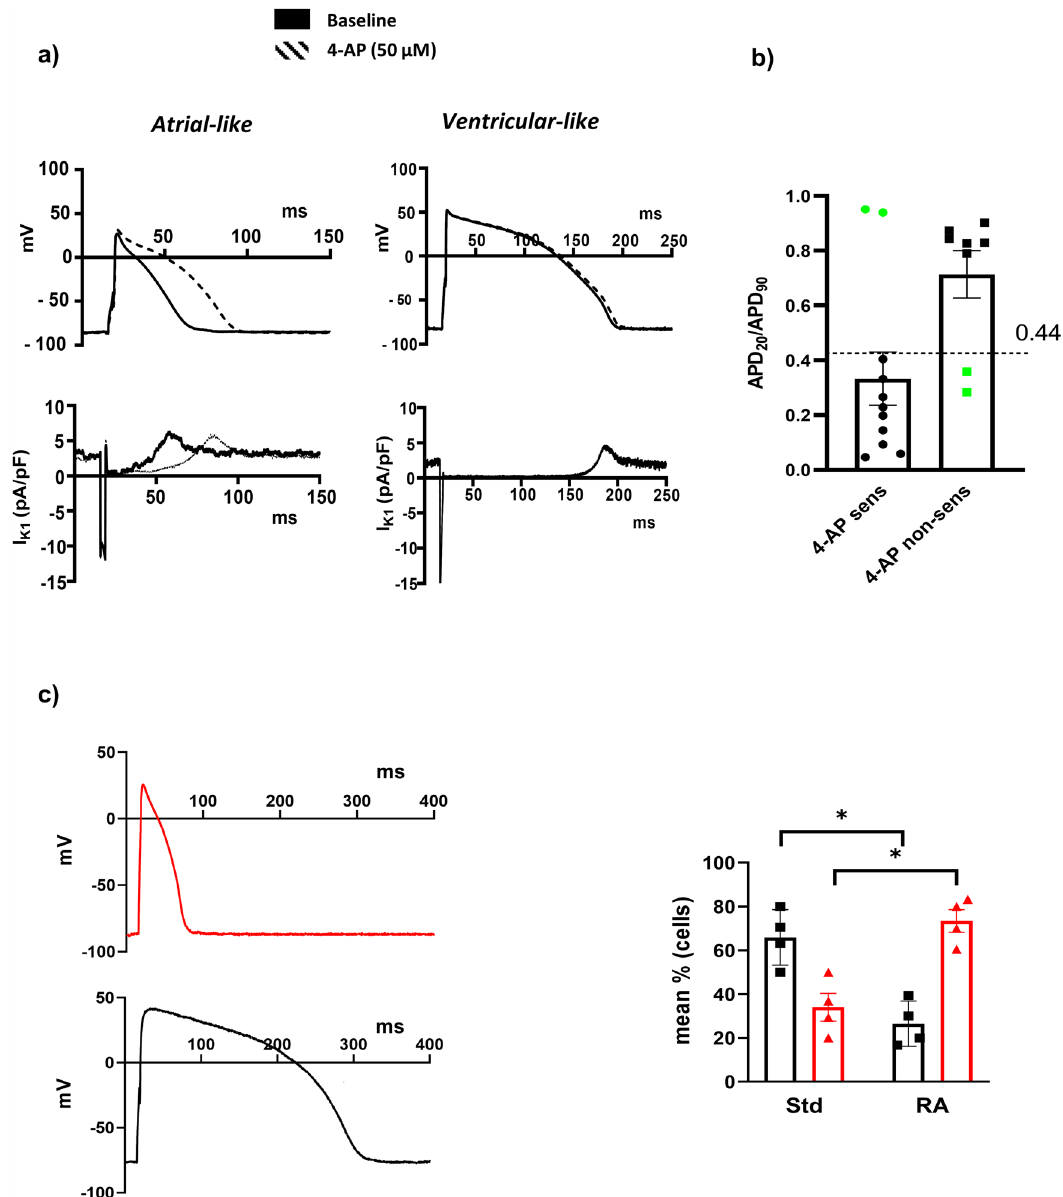
Fig. 5 Based-model pharmacological validation and RA ef fi ciency evaluation. a Example of cut-off- sensitive and non-sensitive based atrial- and ventricular-like APs recorded during the baseline condition and the superfusion of I Kur -speci fi c blocker 4-aminopyridine (4-AP, 50 µ M). b Distribution of APD 20 /APD 90 values of 4-AP-sensitive and 4-AP non-sensitive CMs, with respect to the critical cut-off value (0.44). The “ failing ” cells compared to expectation are showed as green dots in the bar graph ( n = 19 randomly selected cells from 4 independent differentiations) and AP waveforms are shown in the insets. c Atrial- and ventricular-like AP phenotypes represented in the panel and their quantitative change (%) with either the Std- or RA-treated cellular platform (8 independent experiments, 4 Std and 4 RA, each including 20 – 30 recorded cells). (Std standard protocol, RA retinoic acid, APD 20 / APD 90 ratio between APD 20 and APD 90 ). Data shown are mean ± SEM (* p < 0.05 paired t -test RA vs